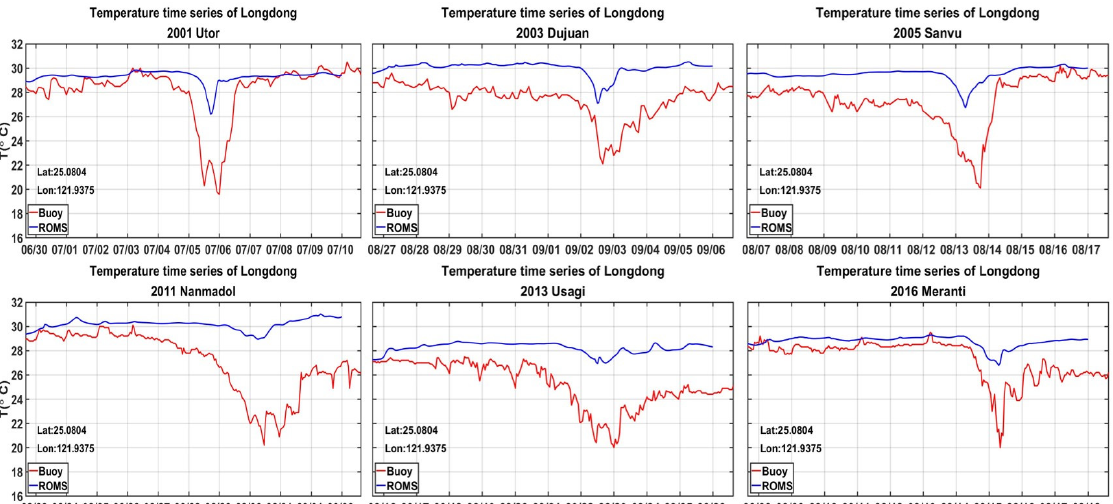
Figure 4. Significant near-surface temperature drops in response to 6 typhoon passages. Red and blue lines denote the temperature variabilities derived from moored buoy temperature meter (installed at 0.6 m depth) and model-simulated SST (temperature at 0 m depth).